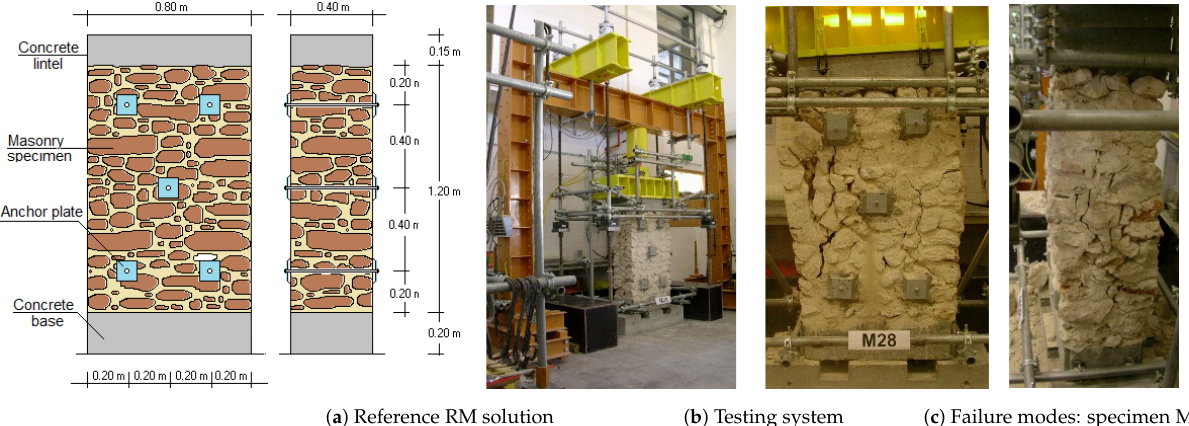
Figure 4. Setup for compression tests of the RM wall specimens and final failure modes [6]. ( a ) Schematic representation of the reinforcement solution with steel connectors (Specimens M41, M44, and M28); ( b ) axial compression testing system; and ( c ) frontal and lateral views of the failure mode of specimen M28. See [2,6] for more